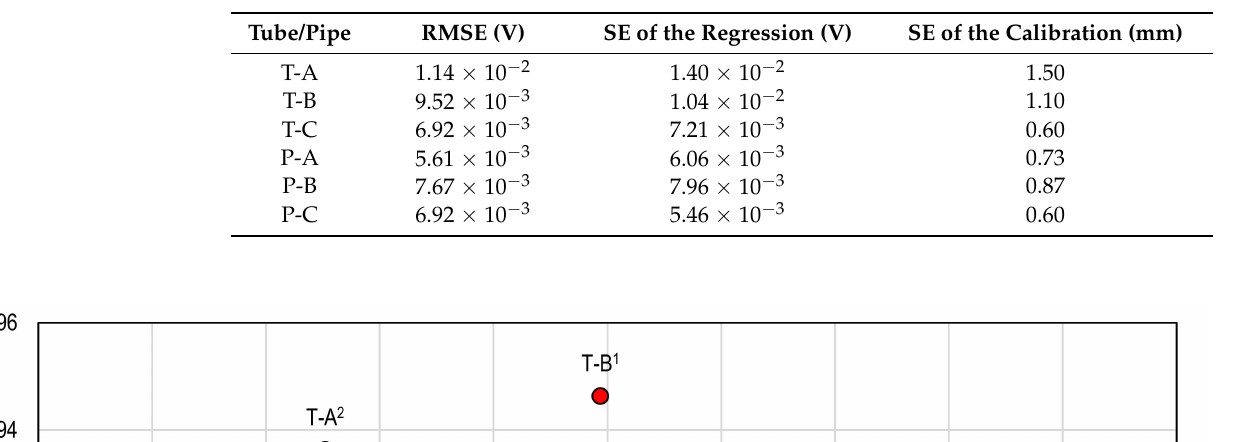
Table 4. Calibration statistics, all the curves’ R 2 was >0.999.